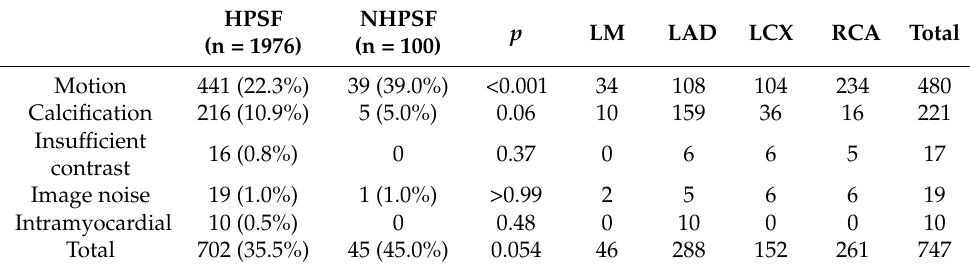
Table 3. Artefact analysis for the 1976 and 100 coronary arteries investigated in the 494, respectively 25 patients with non-diagnostic initial scans. HPSF: high-pitch spiral scan first; NHPSF: non-high- pitch spiral scan first. LM: left main coronary artery; LAD: left anterior descending coronary artery; LCX: left circumflex coronary artery; RCA: right coronary artery; intramyocardial: a segment of the coronary artery is surrounded by myocardial tissue by >50% of the